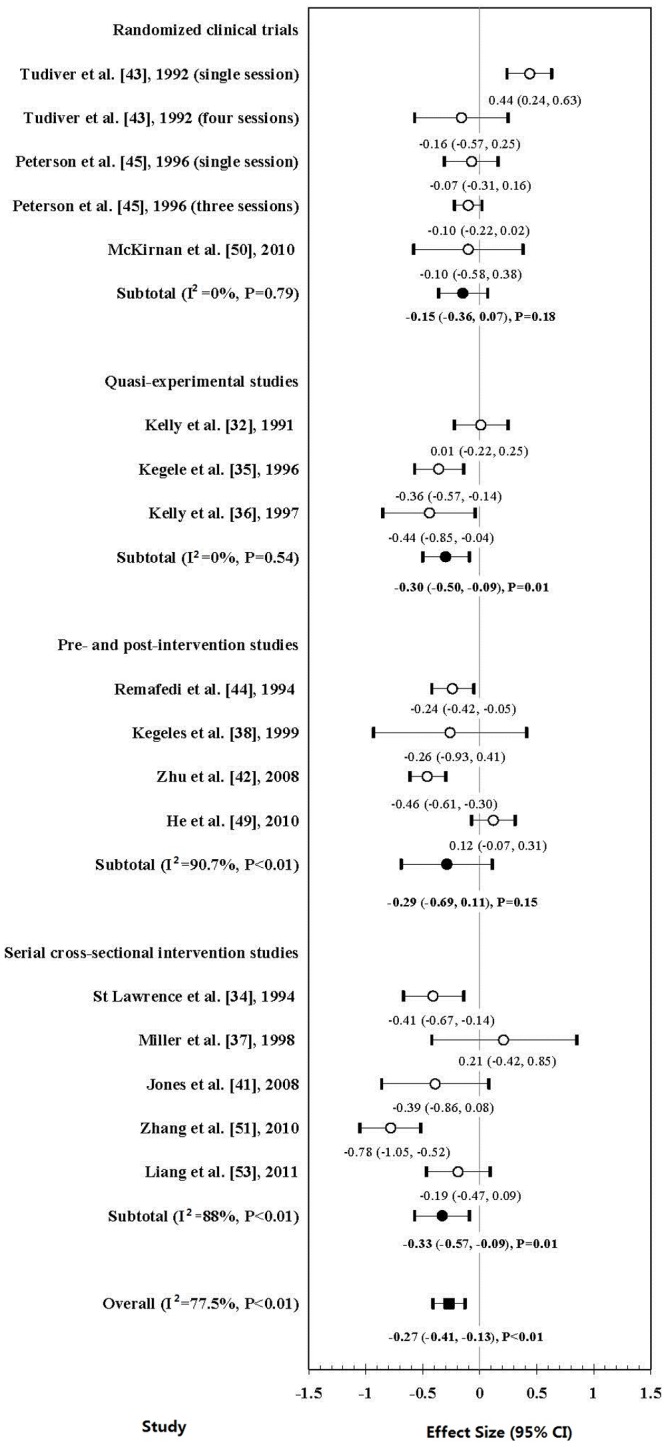
Forest plot of the effect sizes of peer-led interventions on change of unprotected anal intercourse among MSM in 15 studies (17 interventions).